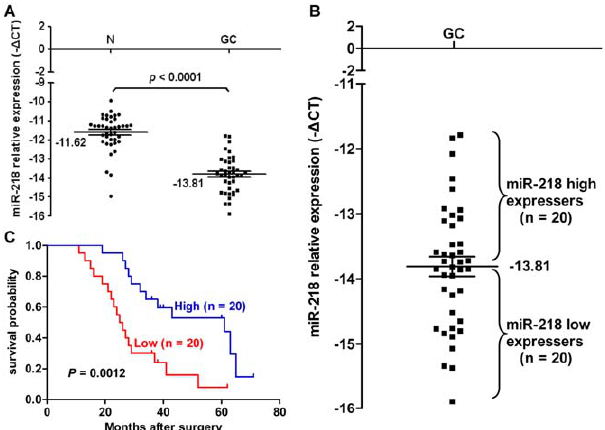
Figure 3. miR-218 expression in clinical GC specimens. (A) miR- 218 was differentially expressed between GC and the corresponding non-neoplastic mucosa (N). The term - D Ct was used to describe the expression level of miR-218 ( 2 D Ct=CtU6 2 CtmiR-218). A significant difference was detected in the mean value of miR-218 expression between these two groups ( P , 0.0001, t=10.62, paired t -test). (B) The same GC samples as in (A) were divided into two groups according to the mean expression of miR-218 (mean, 2 13.81). Cases with levels of miR-218 below the mean were miR-218 low expressers ( n =20), and those with levels of miR-218 above the mean were miR-218 high expressers ( n =20). (C) Kaplan–Meier survival curve and log-rank test for GC patients between high and low miR-218 expressers. miR-218 expression demonstrated a significant relationship with patient survival (log-rank, P